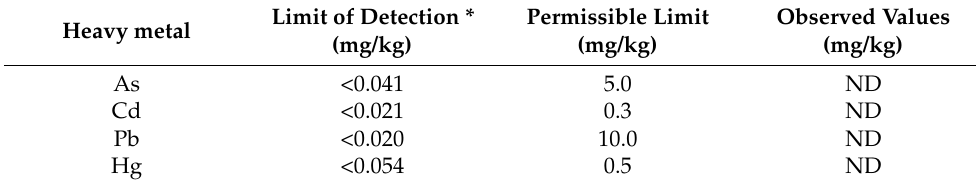
Table 12. Heavy metal concentrations in rhein-rich extract. Limit of Detection * Heavy metal (mg/kg)